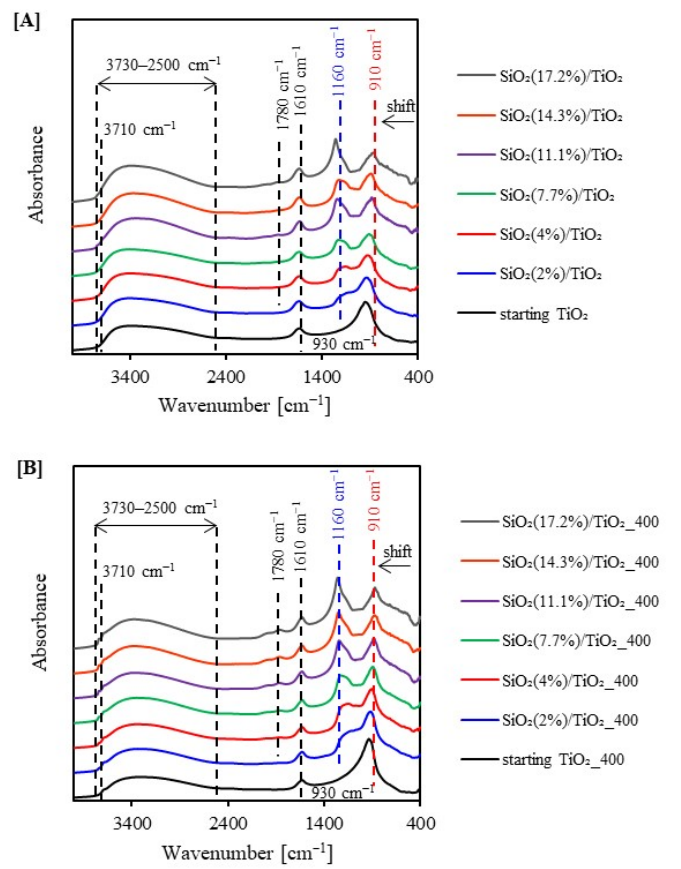
Figure 1. FT-IR/DR spectra of starting TiO 2 and silica-modified TiO 2 prior ( A ) and after heat treatment ( B ).